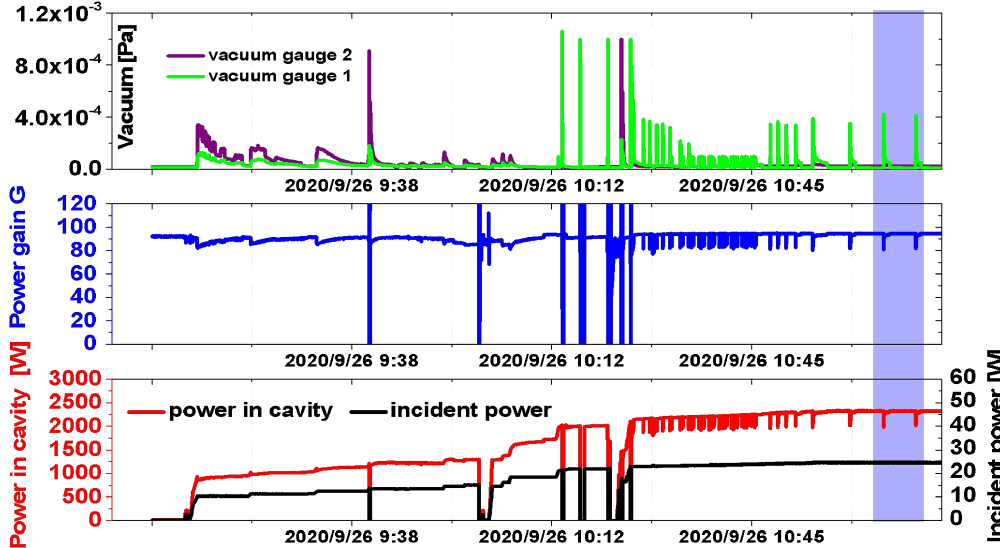
FIG. 24. High-power test results with the left short at z ¼ − 76